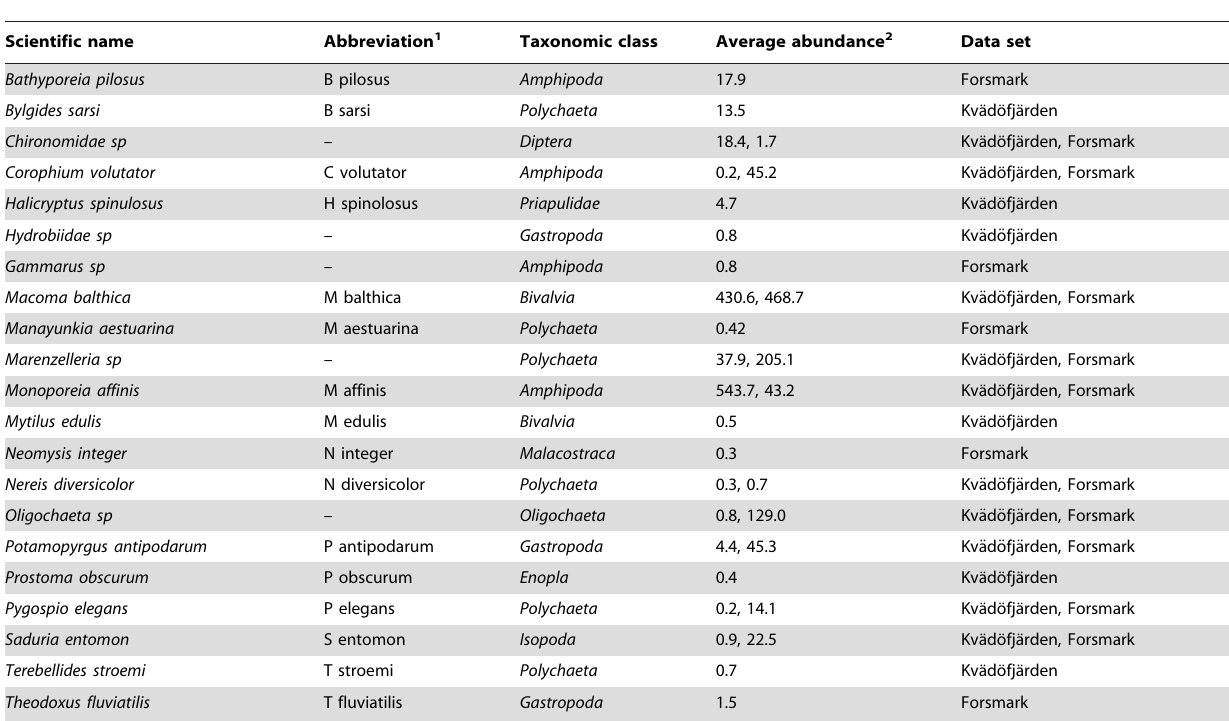
Table 1. Occurrence of the species included in the data sets assessed in the study, Kva¨do¨fja¨rden (BP) and Forsmark (BoS).